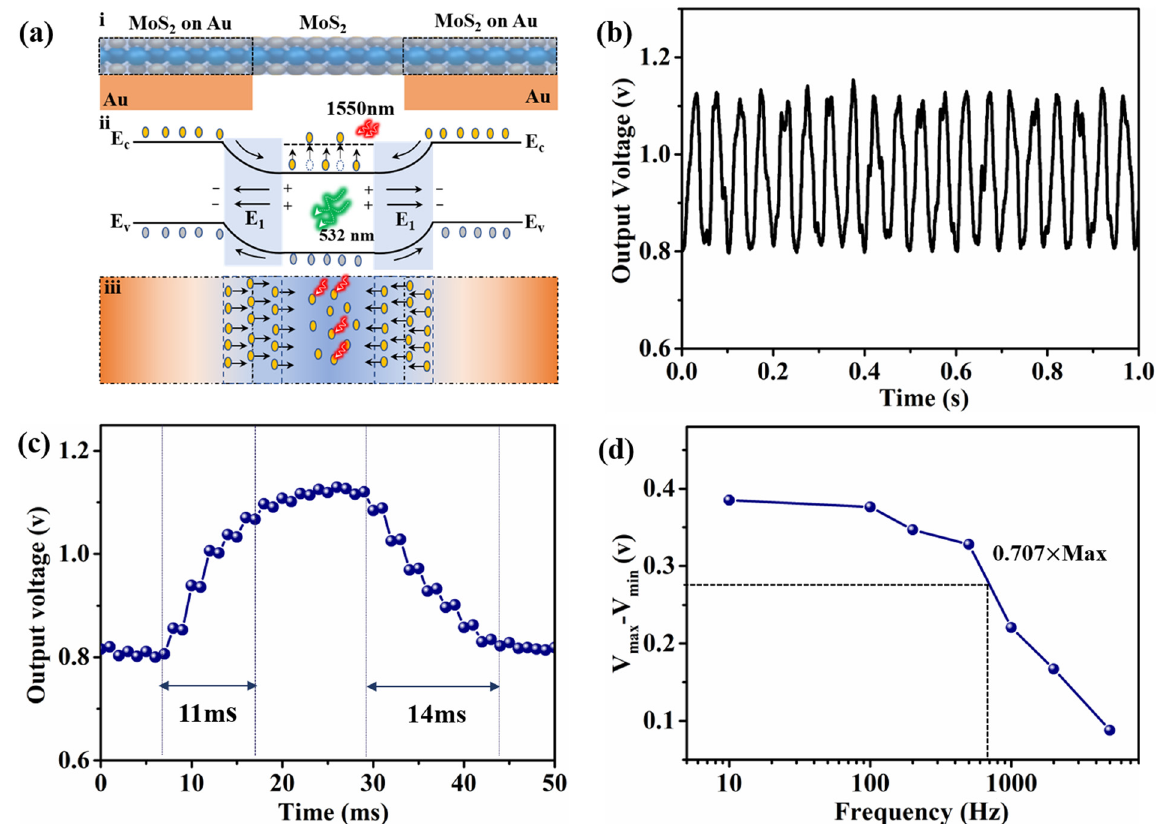
Figure 5: Frequency response of MoS 2 -plasmonic nanoslit modulator. (a) Schematicof dynamicresponsemechanism. (i) Onboth sides of the nanoslit,MoS 2 is in contact with the Au layer; onthe nanoslit, MoS 2 is suspended. (ii) Energy band diagram of MoS 2 homojunction. (iii) Excited electron movement driven by a built-in electric fi eld. (b) Measured signal light waveform changes with time. (c) Rise time and fall time of proposed modulator. (d) Output voltage changes at different frequencies.